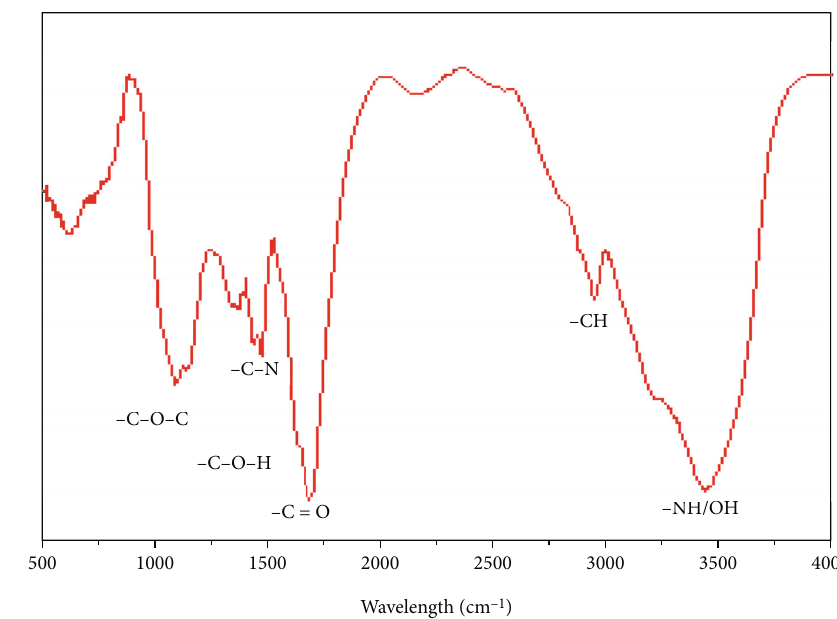
Figure 2: FTIR spectrum of polymeric GA/AM hydrogel.